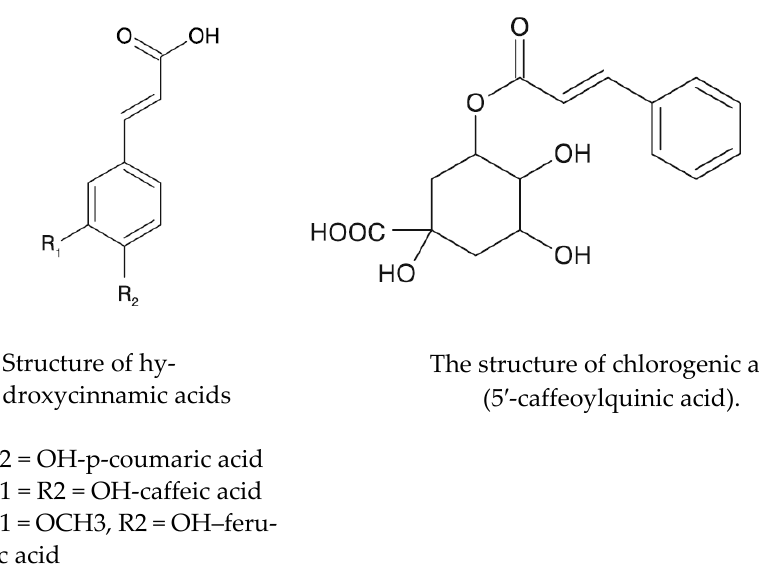
Figure 1. Structures of hydroxycinnamic acids and chlorogenic acid [6].